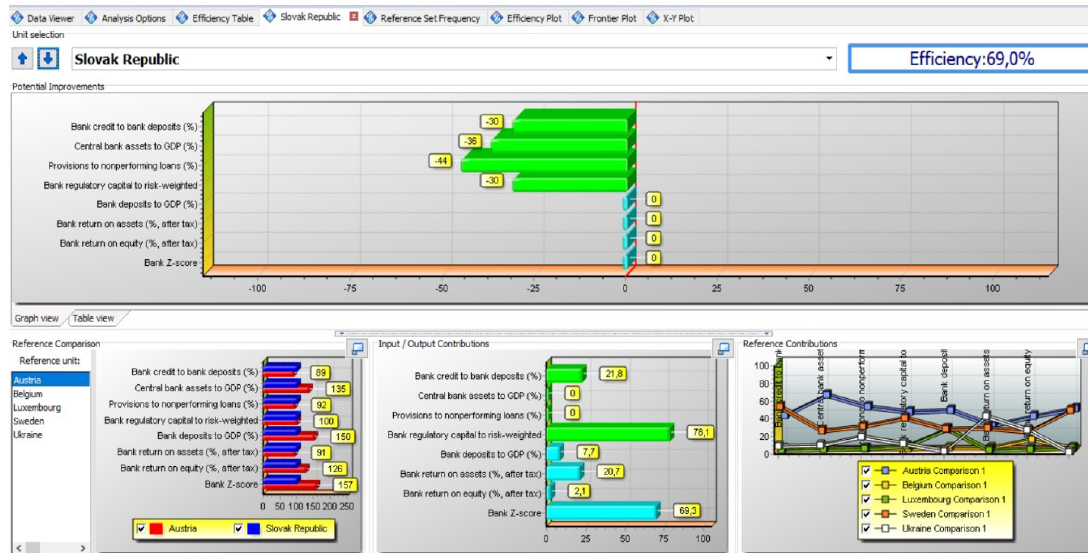
Figure C1. Analysis of the results and potential for improving the efficiency of the French banking system as of 2020 for the BCC model